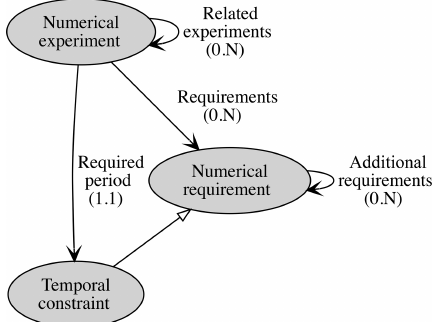
Figure 3. NumericalExperiments are designed and governed by MIPs. Each numerical experiment is defined by NumericalRequire- ments , including a mandatory constraint setting out the required period of the numerical experiment. Numerical requirements may have complicated internal structures (see Fig. 4). In both this and the next figure, arrows and their labels use the Unified Modelling Language (UML) syntax to describe the relationships between the entities named in the bubbles. UML provides a standard way to vi- sualize the components of a system and how they relate to each other; different styles of arrow denote different types of relation- ship. The UML relationships used here and in Fig. 4 are described in Table 1 of Hassell et al. (2017); a short primer on UML concepts can be found in Appendix A of Hassell et al.